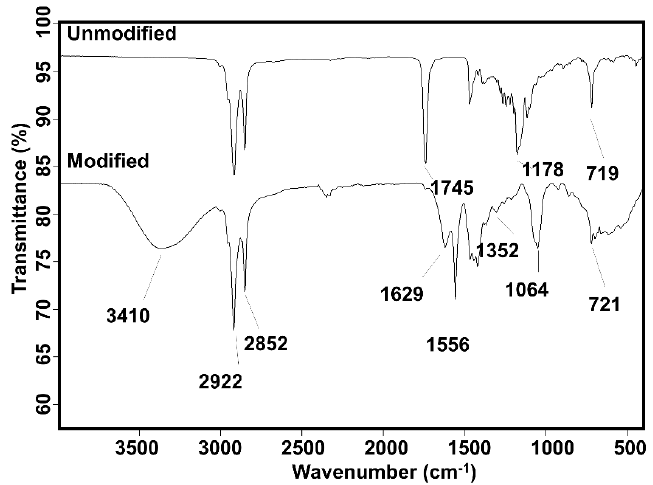
Figure 2. FTIR spectra of unmodified and modified palm stearin.